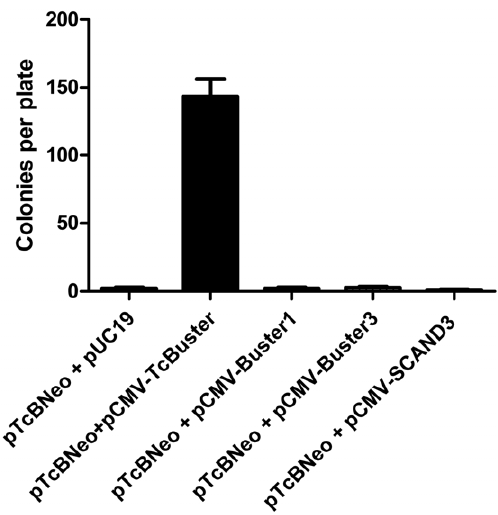
Figure 3. The TcBuster transposase-related human proteins Buster1, Buster3 and SCAND3 cannot insert the TcBuster transposon into the mammalian genome. HEK-293 cells were split onto 60 mm dishes and transfected with 1800 ng of pTcBNeo and 200 ng of Buster plasmid using FuGene6. The transfected cells (10 m l) were diluted into media containing G418 in 10 cm dishes and allowed to grow for two weeks. The resulting colonies were stained and counted (n=3; error bars represent the standard error of the